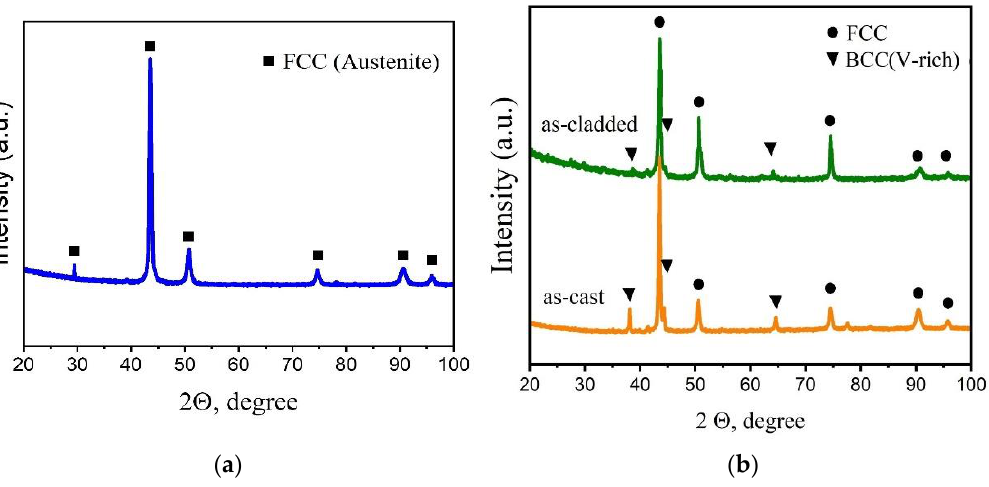
Figure 5. X-Ray diffraction patterns: ( a ) substrate; ( b ) Al 0 . 25 CoCrFeNiV HEA for as-cast and as-cladded states.